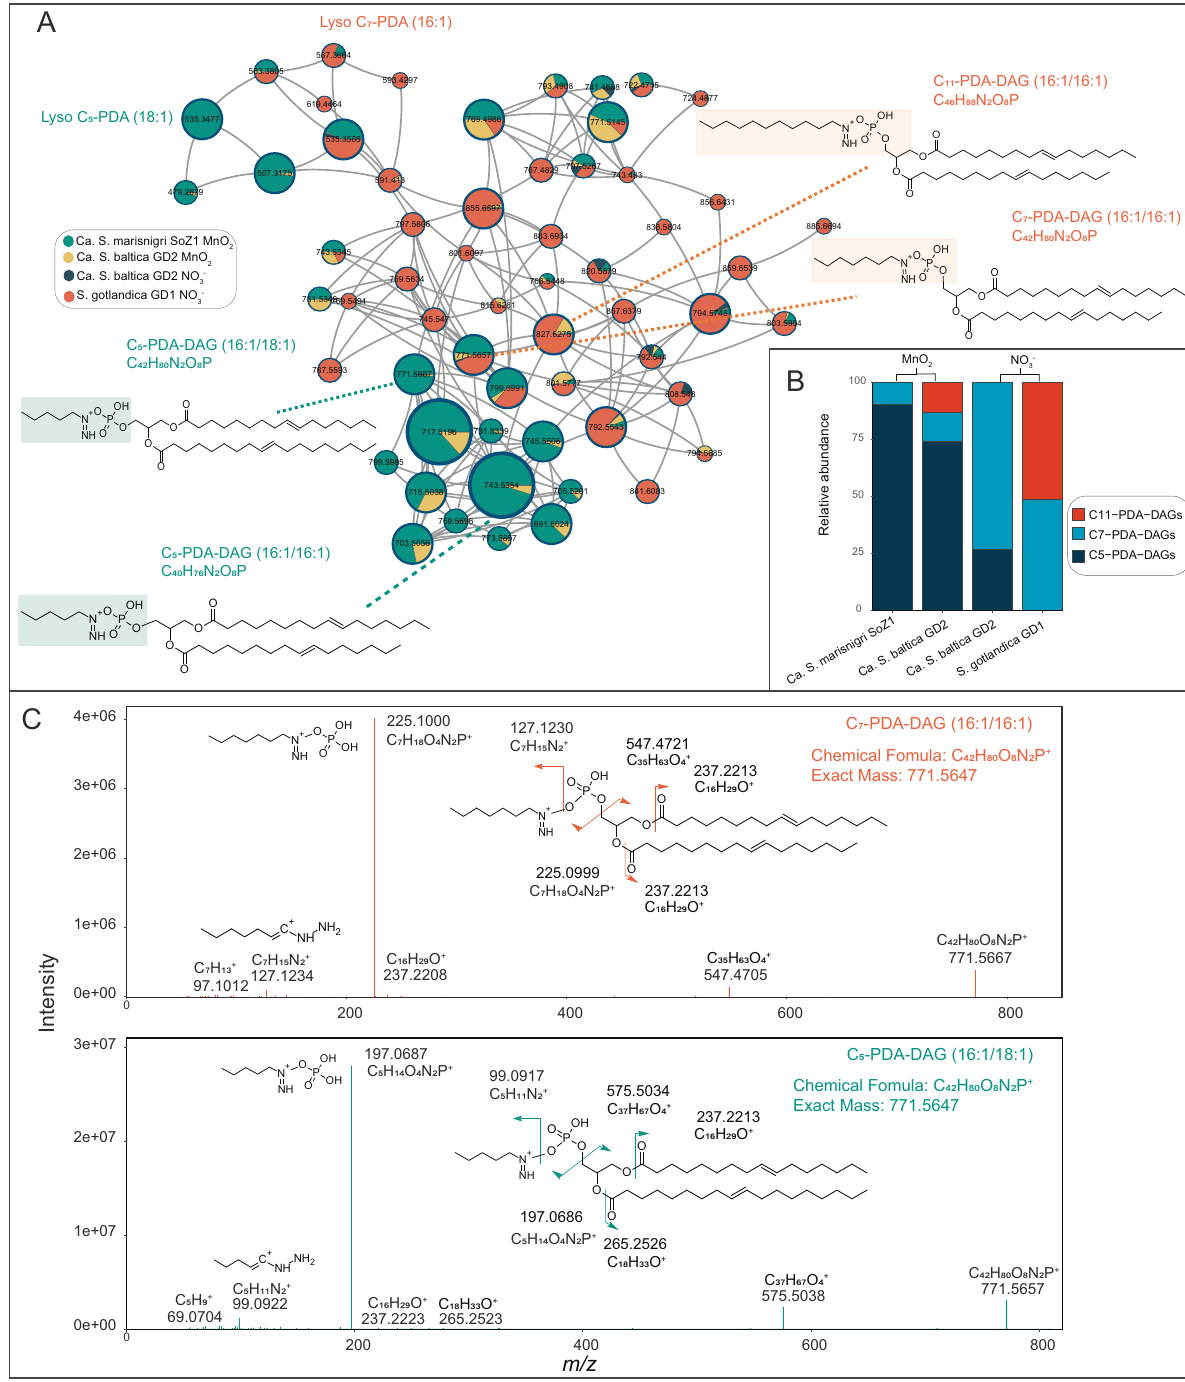
Fig. 3 A The molecular subnetwork of the tentatively identi fi ed PDA-DAG lipids. Pie charts shown in subnetwork are the same as nodes shown in Fig. 1, representing different lipid structures. The size of the pie charts represents the summed intensity of all the species using various electron acceptors. Colors of pie chart represents the fractional abundance of this lipid among all the Sulfurimonas species grown at various conditions. B PDA-DAG lipid structures and their fractional abundance of total PDA-DAGs found in subnetwork Fig. 3. C MS 2 spectra of two PDA-DAGs that have the same elemental composition (EC of C 42 H 80 O 8 N 2 P + ; m/z 771.5647) but differ in the size of the alkyl chains of the polar headgroup and the number of carbon atoms of the acyl moieties. been detected in other organisms or environments [34, 37]. A search using the Mass Spectrometry Search Tool (MASST) However, none of the databases showed matches to these of over 1000 public LC-MS datasets available in the GNPS unique lipids, suggesting that either it was due to a database platform database (including lipidomes, metabolomes etc.) was bias or these novel components are potentially indicative of performed to see whether lipids structurally similar to the this taxonomic group, because of their speci fi c metabolism or PDA-DAGs detected in this study of Sulfurimonas cultures had